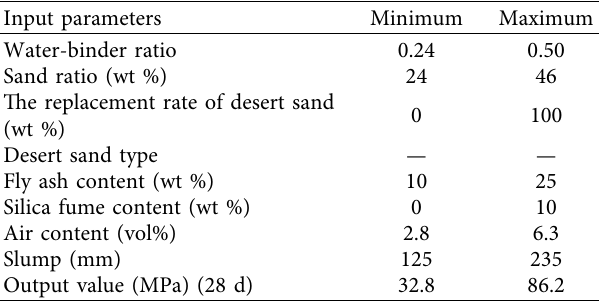
Table 2: Range of input and output parameters in the